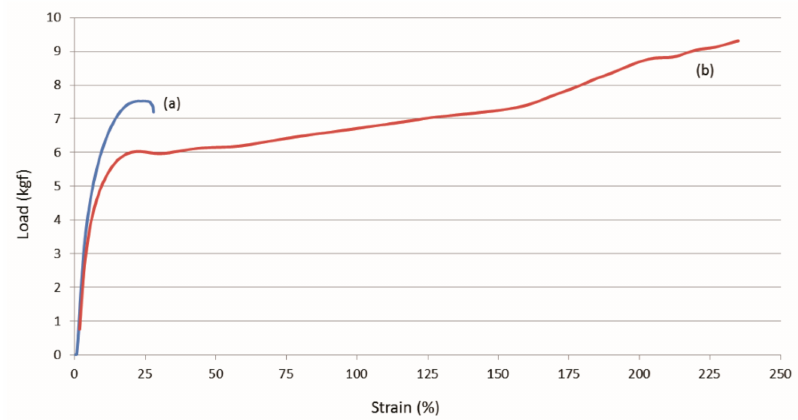
Figure 15. Strain responses of asr-N-6 / nuc-N-6 ( a ) and asr-N-6 / asr-N-6 ( b ) film sandwiches to applied loads obtained with permission from [45]. Copyright 2011 American Chemical Society.